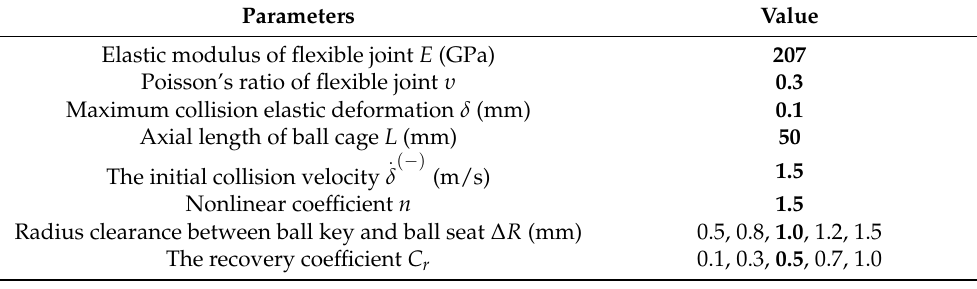
Table 2. The material parameters and dimensions of flexible joint. Parameters